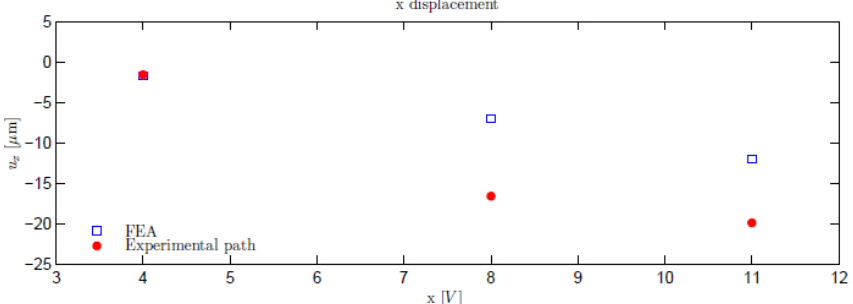
Figure 10. Comparison of the displacements obtained by the FEA model (blue squares) and the experimental measurements (red plain circles).